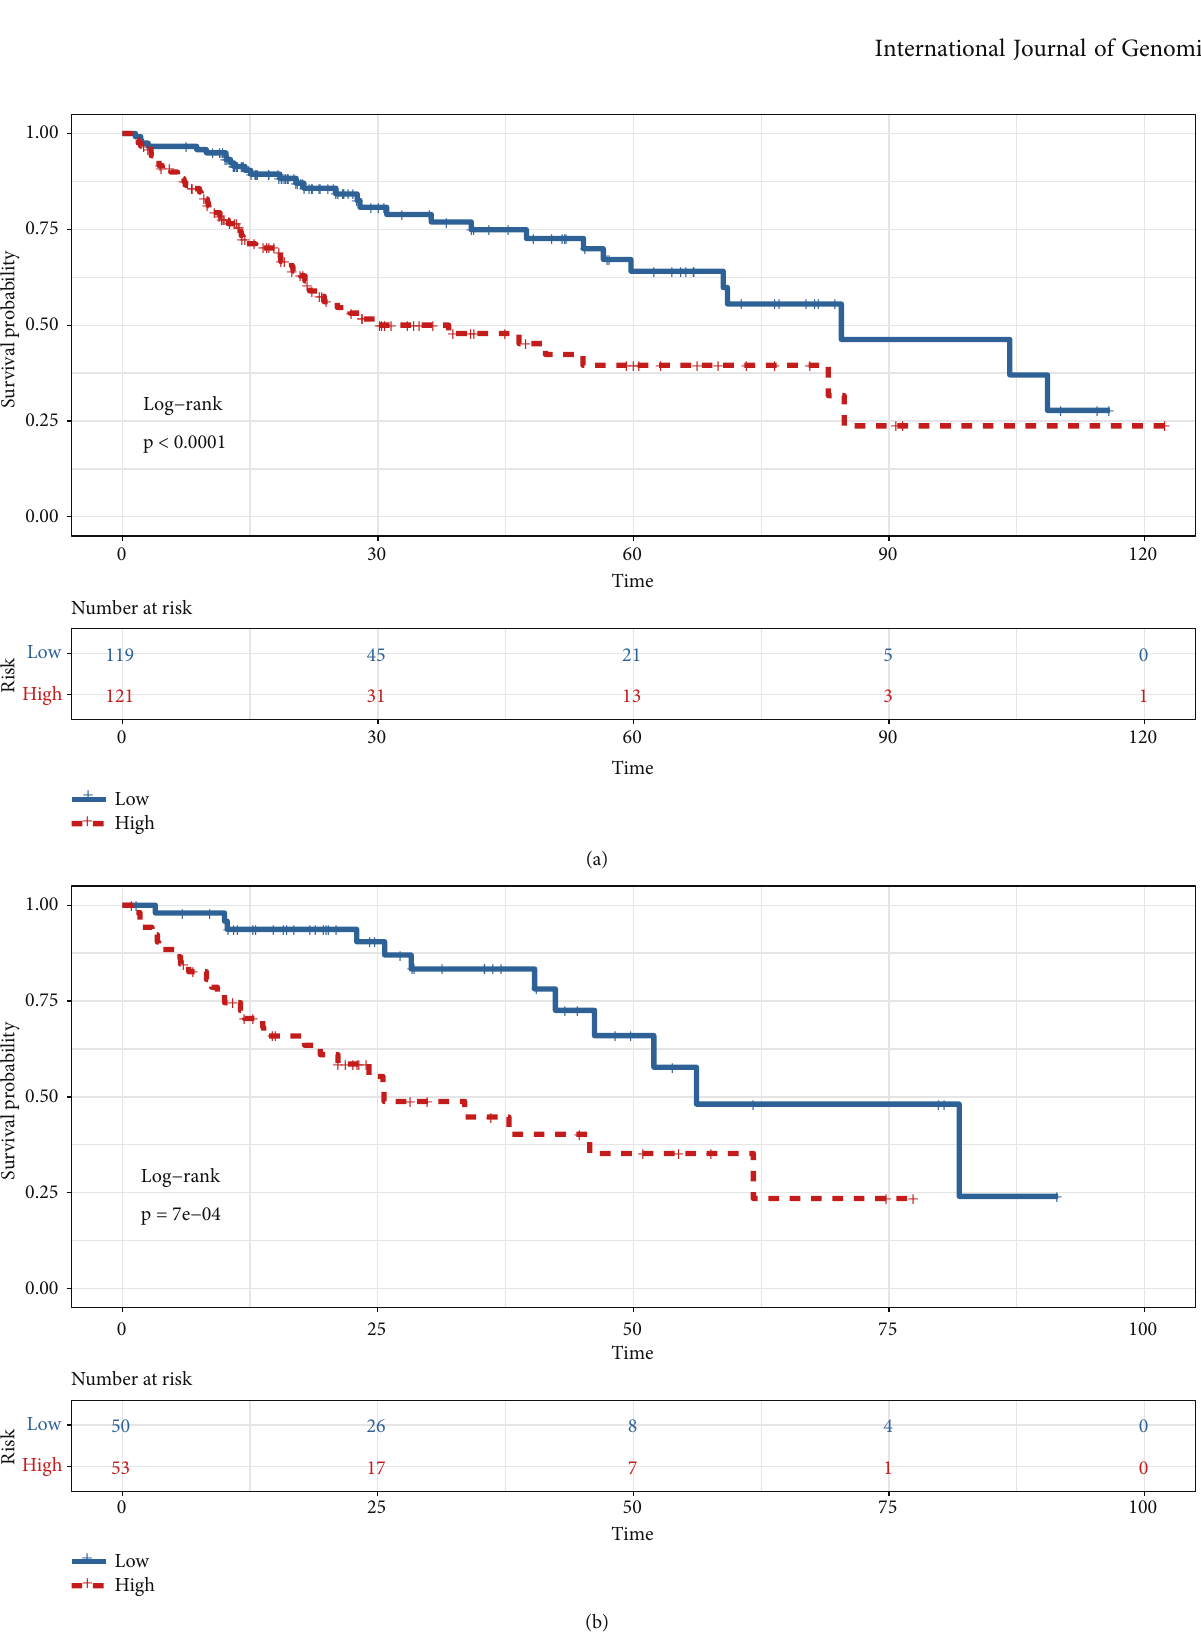
Figure 5: The prognostic role of the fi ve-LLPS gene risk score signature in HCC. (a) The OS of patients in the fi ve-LLPS gene risk score signature low- and high-risk groups in the training dataset. (b) The OS of patients in the fi ve-LLPS gene risk score signature low- and high-risk groups in the validation